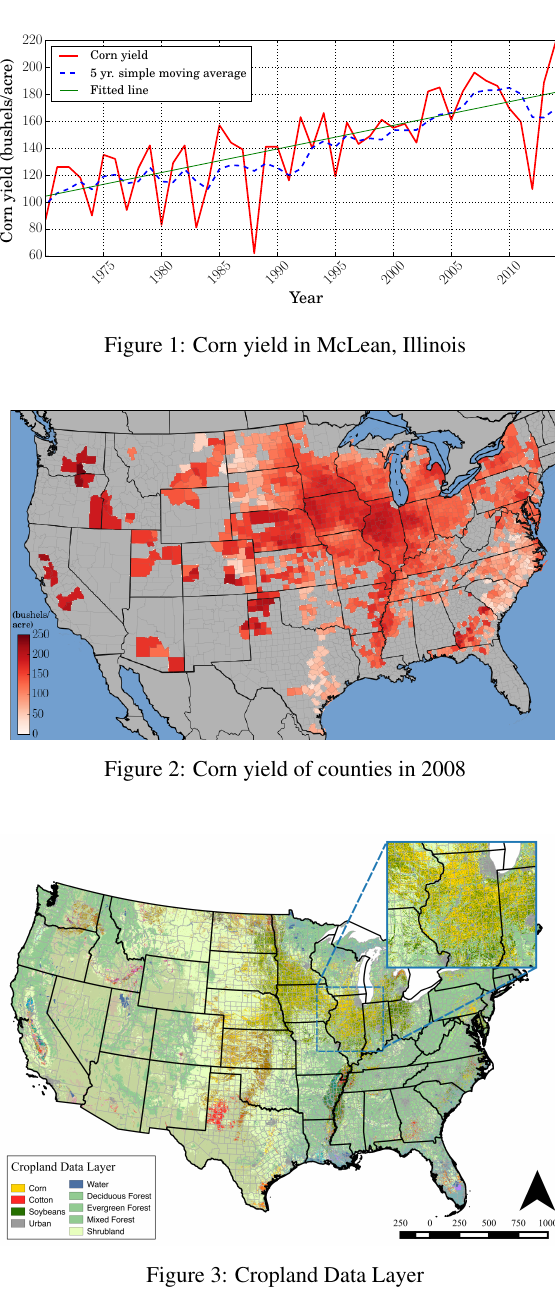
2.1.2 Cropland Data Layer The cropland data layer